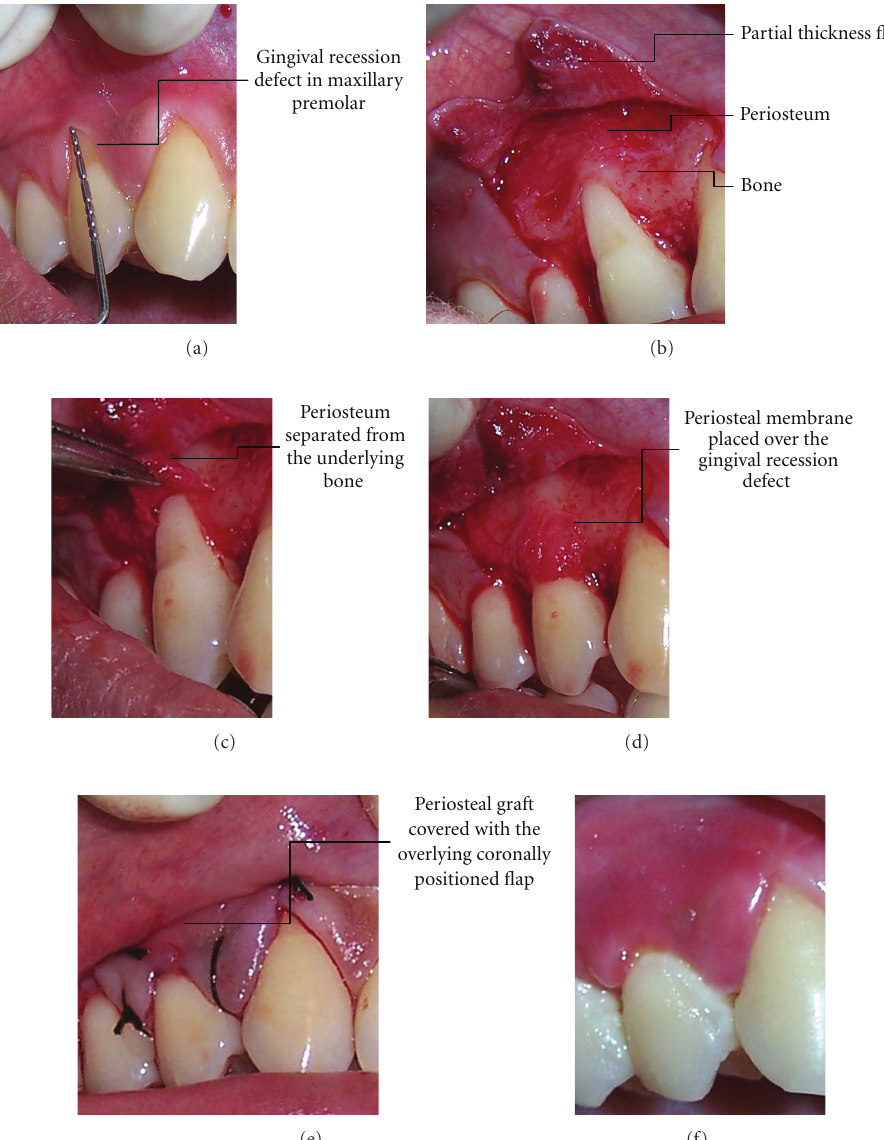
Figure 3: The use of periosteum for the treatment of gingival recession defect. (a) Clinical photograph showing gingival recession defect in relation to the maxillary first right premolar. (b) A partial thickness flap lifted to expose the underlying periosteum covering the alveolar bone. (c) The periosteum which is separated from the underlying bone. (d) The periosteum is used as a pedicle graft for covering the recession defect. (e) The periosteal graft is covered with the overlying coronally advanced flap which is sutured using 4–0 silk suture. (f) Satisfactory treatment